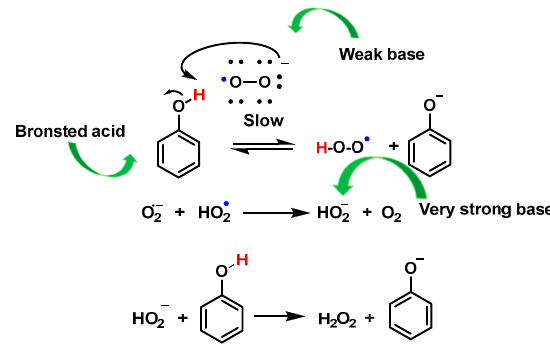
Figure 58. Reaction of phenol with superoxide anion.